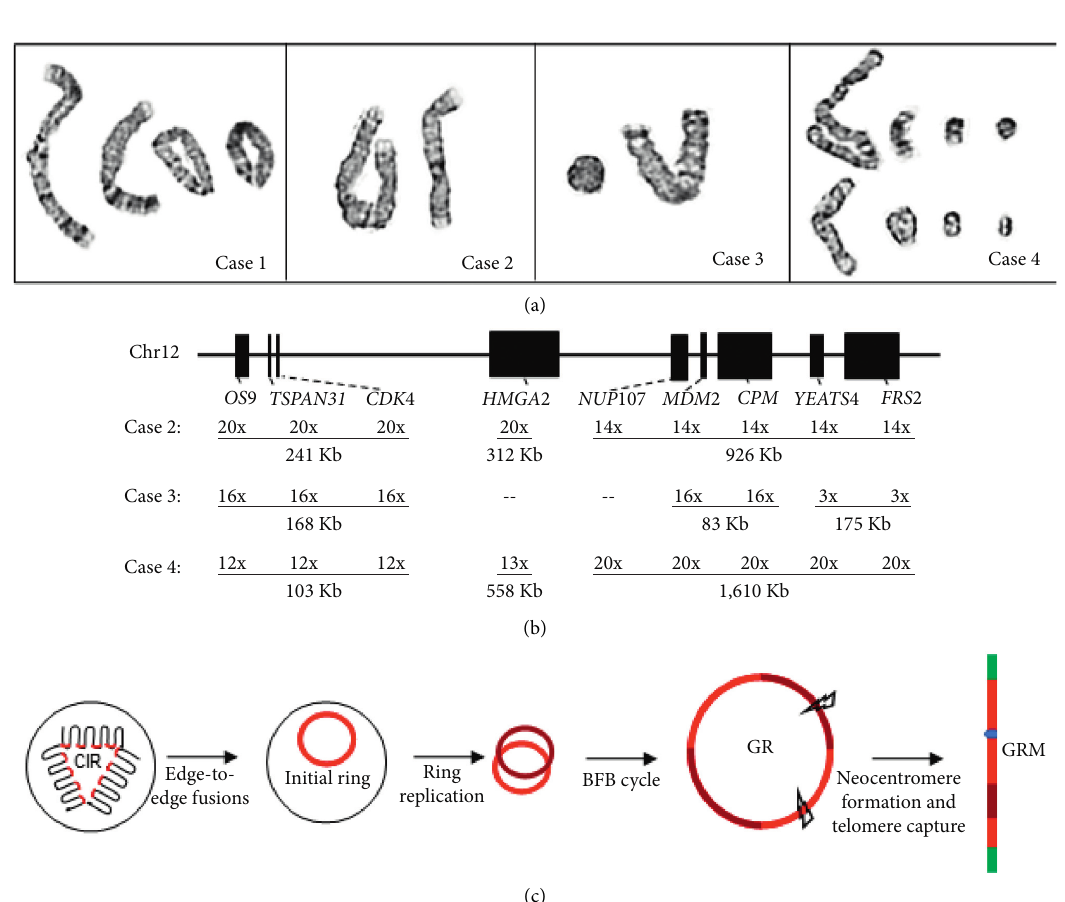
Figure 1: Cytogenomic findings in the three cases and a cellular process for the giant ring (GR) or giant rod marker (GRM). (a) Chromosome results showing GR or GRM in cases 1 to 4. (b) Amplification levels of SCNAs and putative oncogenes in the core segment of 12q14.1q15 in the three cases are given by number of copies and size of amplicons in Kb. Dash line “--” indicates normal two copies without amplification. (c) A diagram showing a cellular crisis in a chromosome intermingling region (CIR) for initial ring formation by an erroneous replication (red line), the breakage-fusion-bridge (BFB) cycles for an amplified GR, and neocentromere formation (blue dot) and telomere capture (green bar) for the stabilized